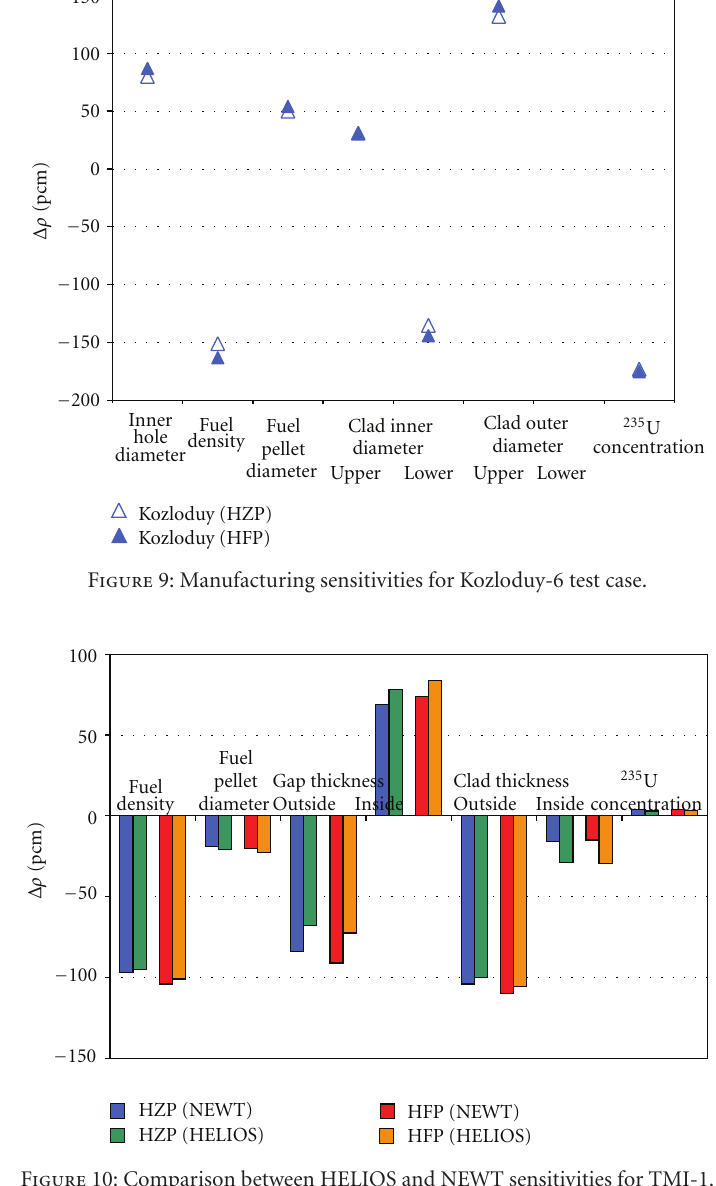
Figure 10: Comparison between HELIOS and NEWT sensitivities for